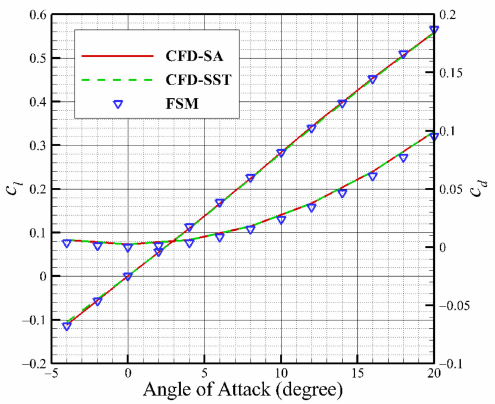
Figure 12. Aerodynamic comparisons of airfoil in jet flow by different